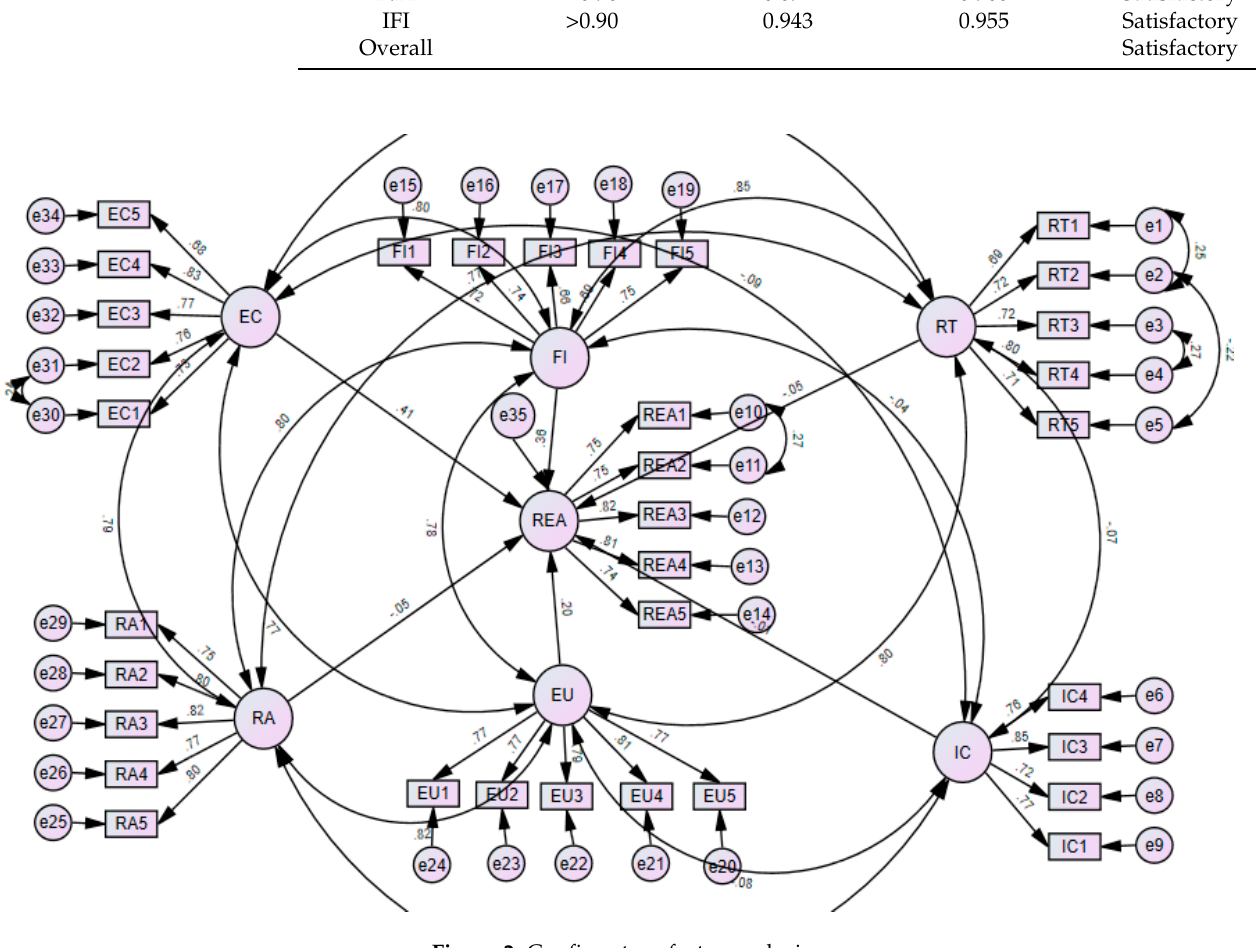
Figure 2. Confirmatory factor analysis.